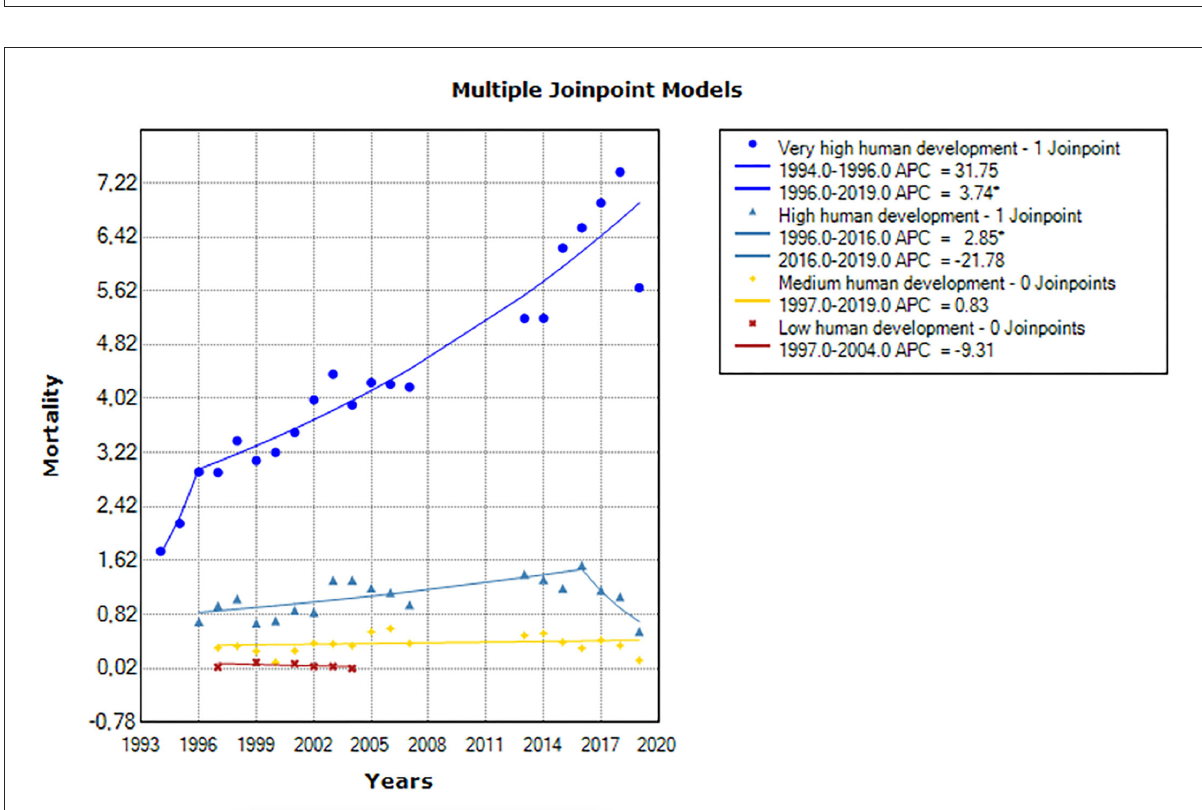
observed for countries in the low-HDI group (APC = − 9.3; 95% CI: